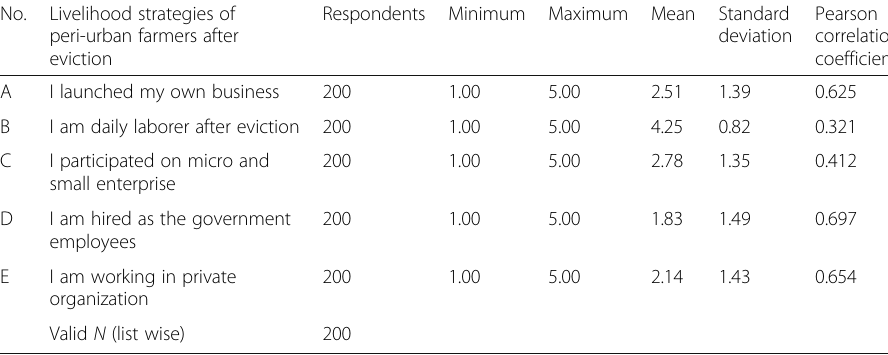
Table 7 Livelihood strategies after eviction of farmers No. Livelihood strategies of peri-urban farmers